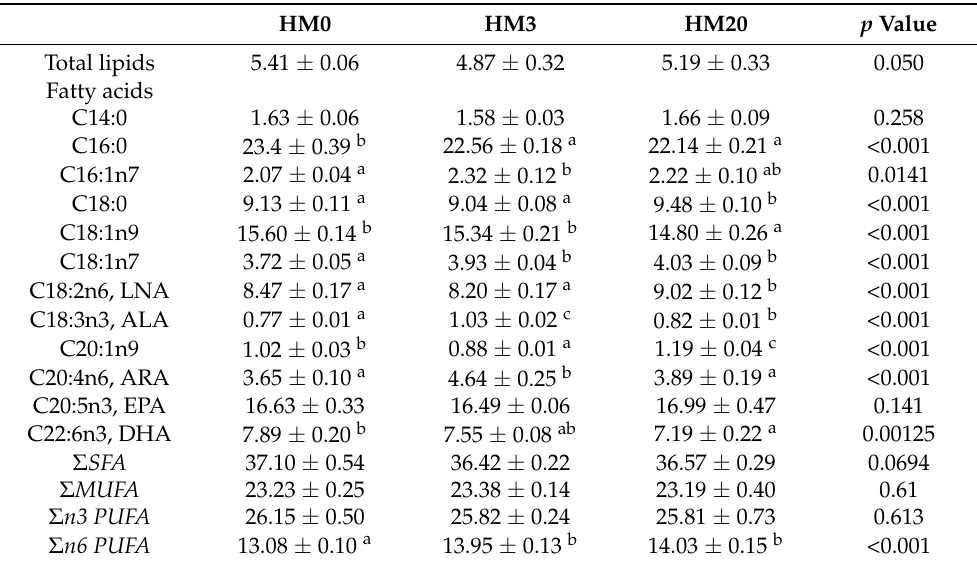
Table 7. Total lipid content (g/100 g of freeze-dried muscle) and fatty acid profile (g/100 g of total FAME) of giant freshwater prawn fed the experimental diets.